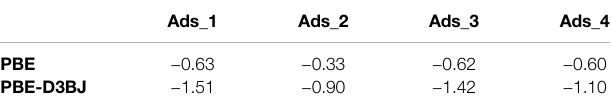
TABLE 2 | Adsorption energies, E (PBC) ads , computed according to Eq. 2 at PBE andPBE-D3BJlevelsoftheoryforeachexploredbindingsite.Valuesaregiven in